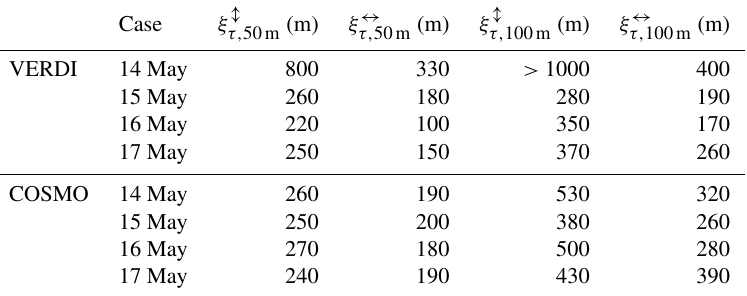
Table 3. Calculated decorrelation lengths ξ τ, meas and ξ τ, sim for the two different spatial resolutions of 50 and 100m along ( ξ ( ξ ↔ τ ) the observed and simulated predominant directions (compare Fig. 7e–h and m–p for 50m spatial